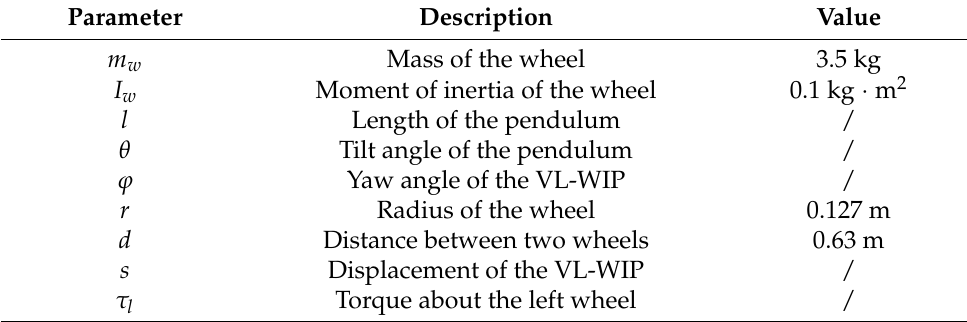
Table 1. Parameters of the decoupled